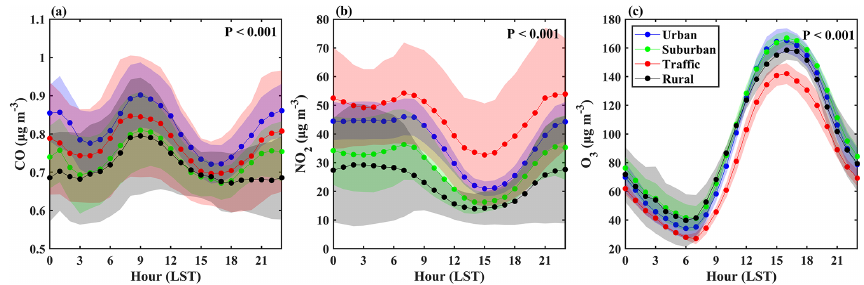
Figure 6. The diurnal variation of (a) CO, (b) NO, and (c) O 3 , at different stations (shading indicates standard deviation; P < 0 . 001 shows statistical significance).